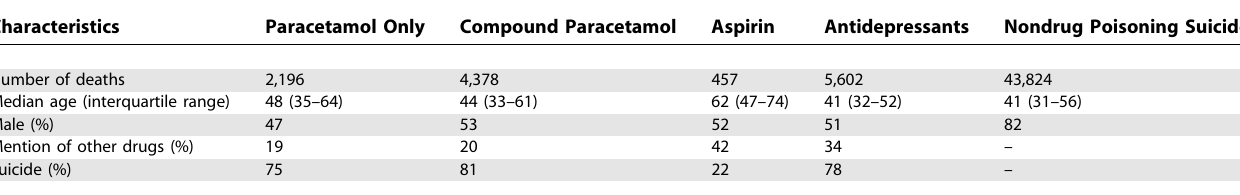
Table 3. Number of Deaths, Median Age, and Percentages: Male, Mentions of Other Drugs, and Suicides, England and Wales 1993–2004